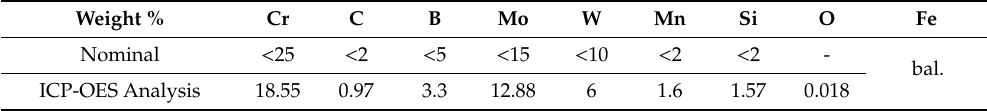
Table 1. Chemical composition (nominal and measured by inductively-coupled plasma optical emission spectrometry (ICP-OES)) of the powder